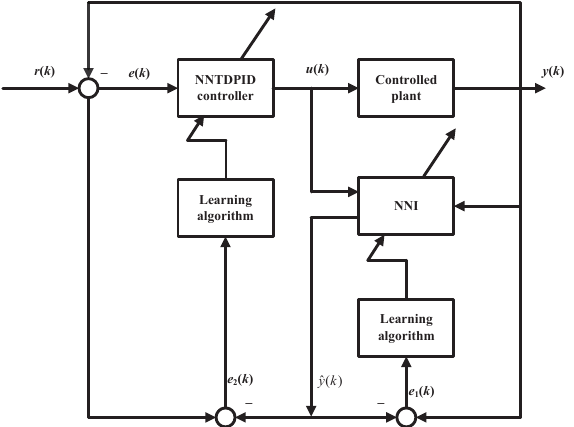
Figure 3. Structure of the control system with a neural network-based discrete-time fractional-order (NNDTFO) PID controller and a neural network identifier